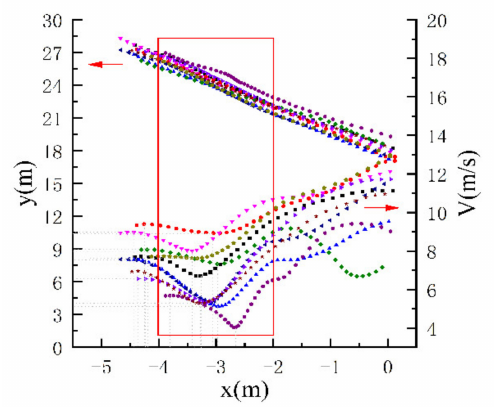
Figure 15. Trajectory and velocity comparison